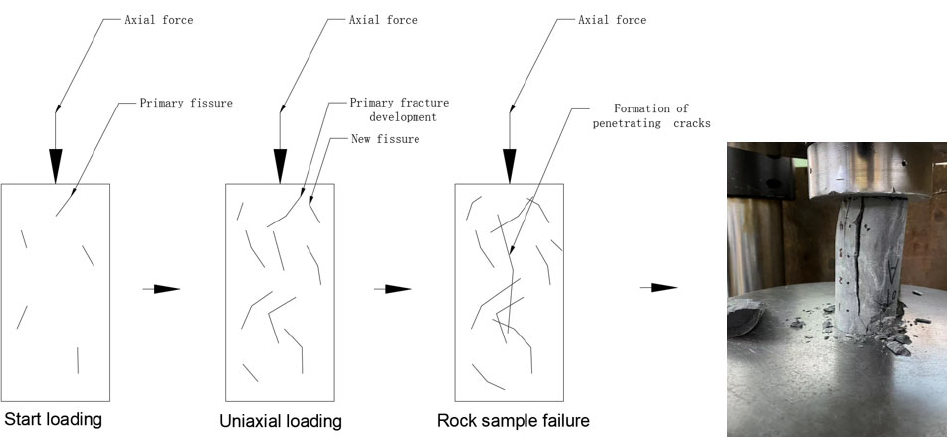
Figure 9. Internal crack development of a rock sample during uniaxial compression test.